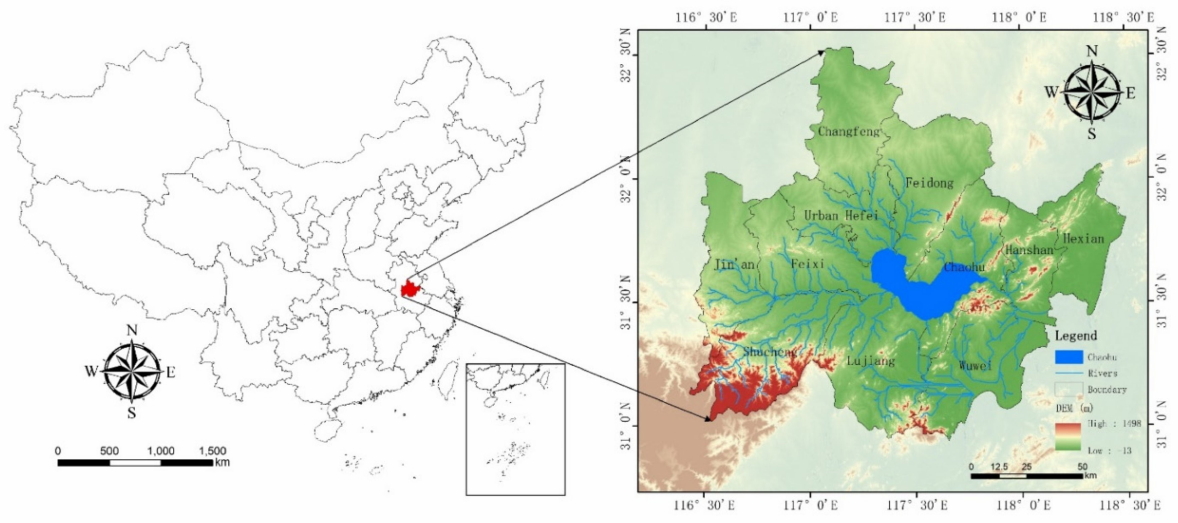
Figure 1. Geographical map of the study